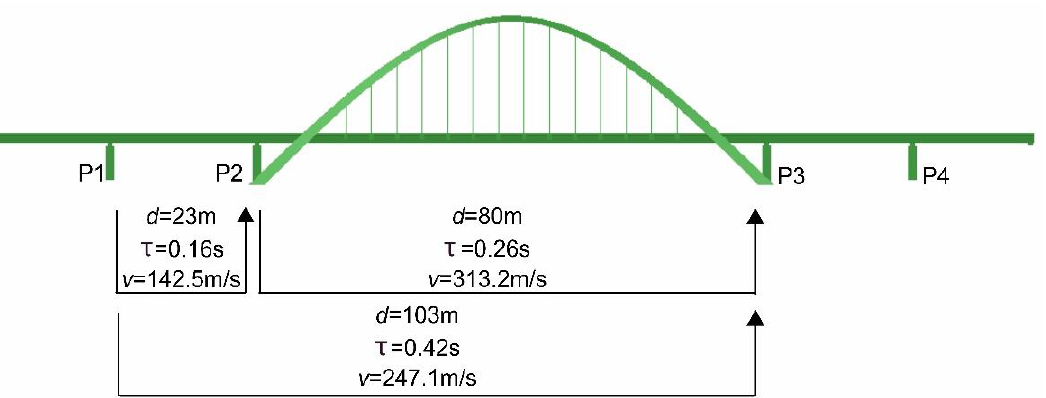
Figure 11. The wave velocities obtained for different soil conditions between particular piers: d -distance, τ -time delay, v -wave velocity.